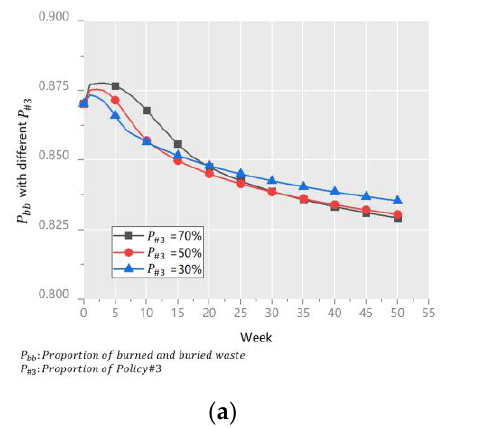
bb ( a ) and S f ( b ) with different P #3